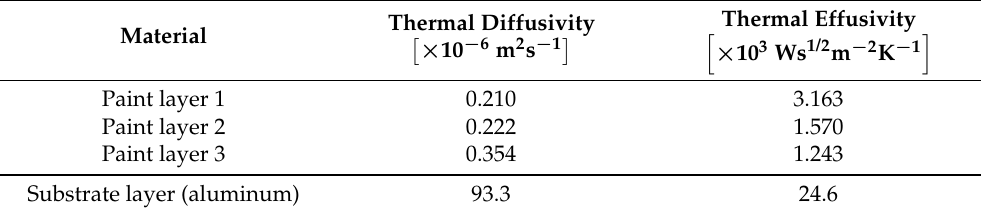
Table 1. Thermal properties used in the